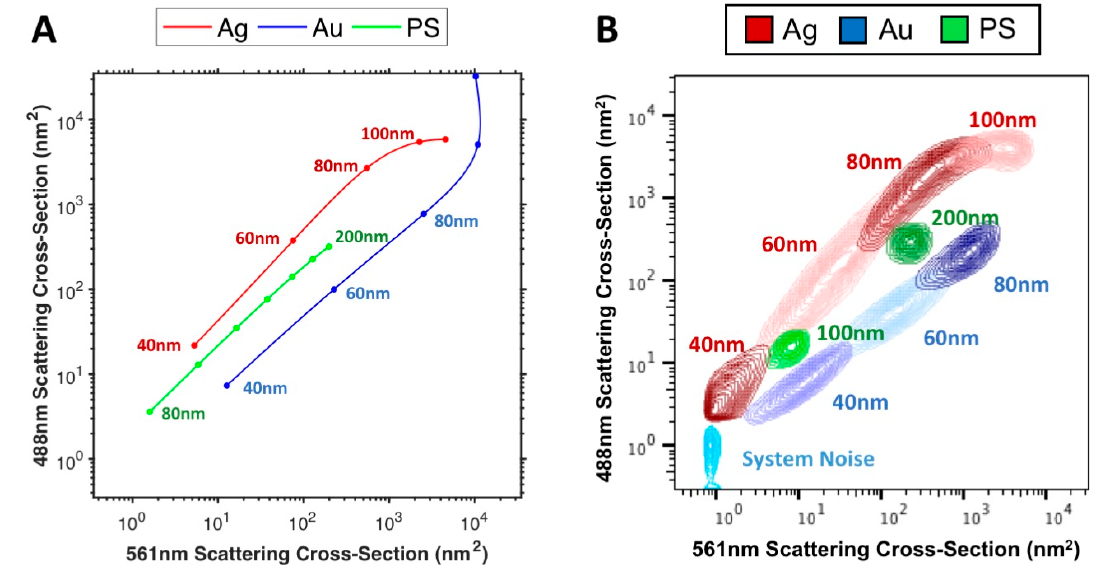
Figure 4. Multi-wavelength particle scattering models of the Astrios EQ ( A ) vs. acquired multi-wavelength particle scattering data on the Astrios EQ ( B ). Modelled data points are at diameters of 40 nm to 120 nm in 20 nm increments for Au and Ag and 80 nm to 200 nm in 20 nm increments for PS.